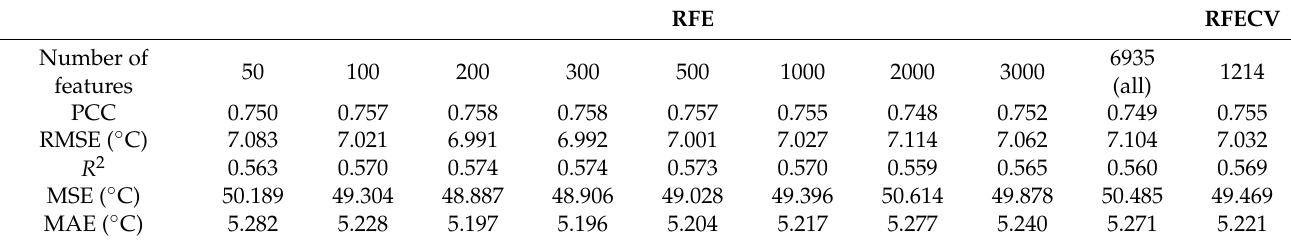
Table 4. Results for feature selection with RFE and RFECV in 10-fold cross-validation. RFE